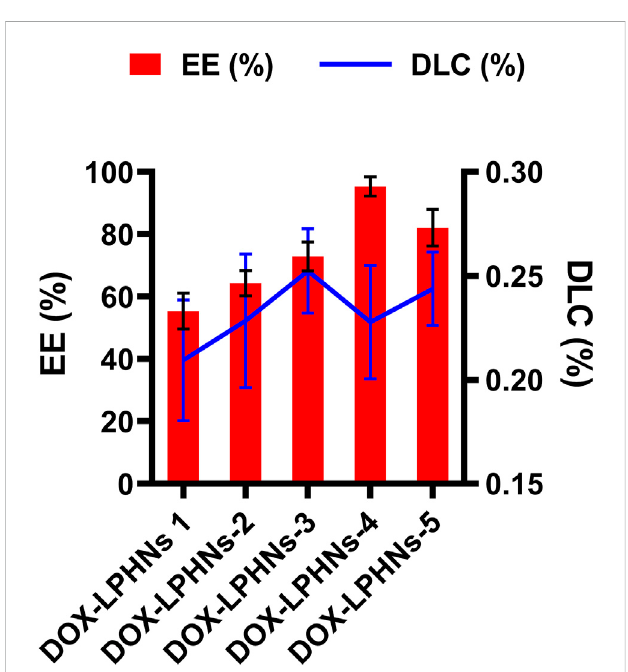
FIGURE 3 Encapsulationef fi ciency%(EE)andDrugLoadingContents%(DLC) of doxorubicin loaded lipid polymeric hybrid nanoparticle formulations.